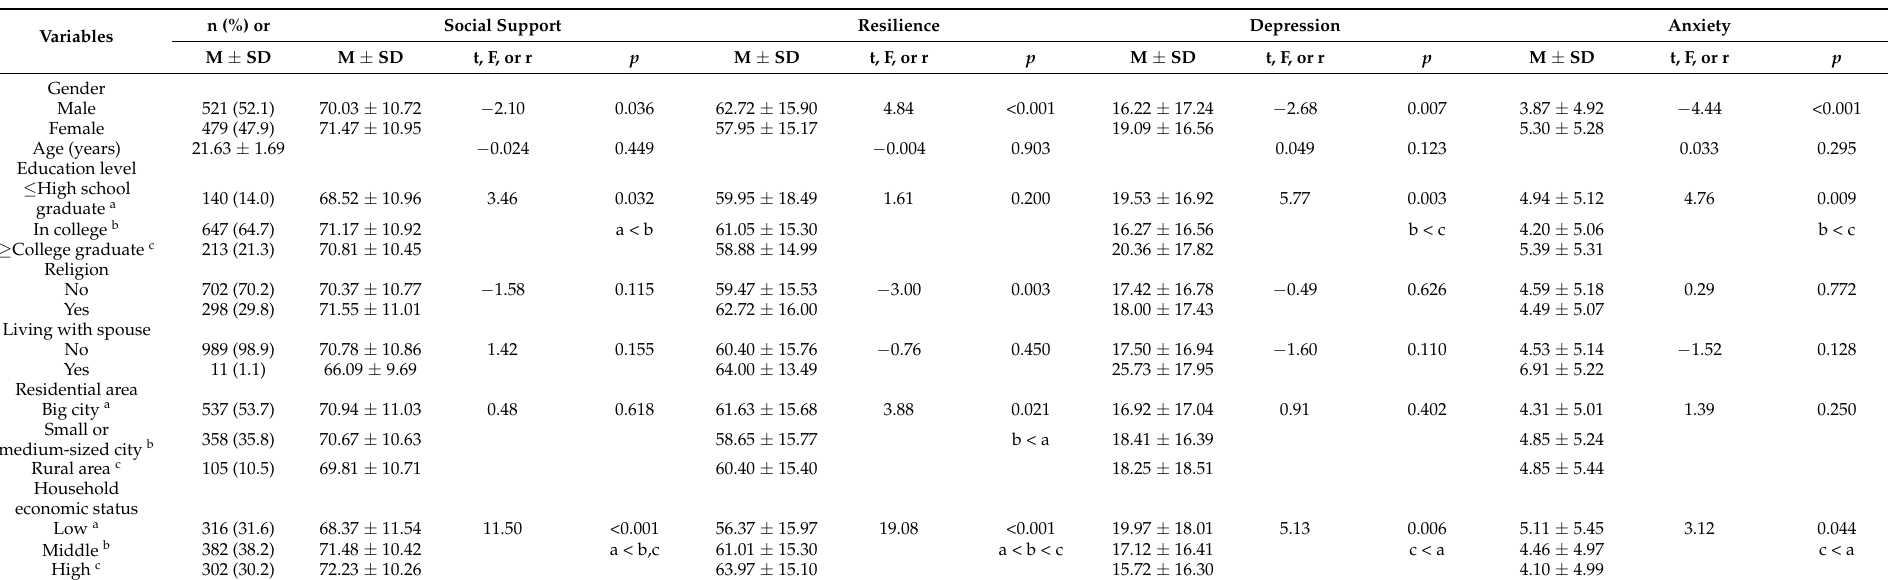
Table 1. Social support, resilience, depression, and anxiety according to demographic characteristics (N =